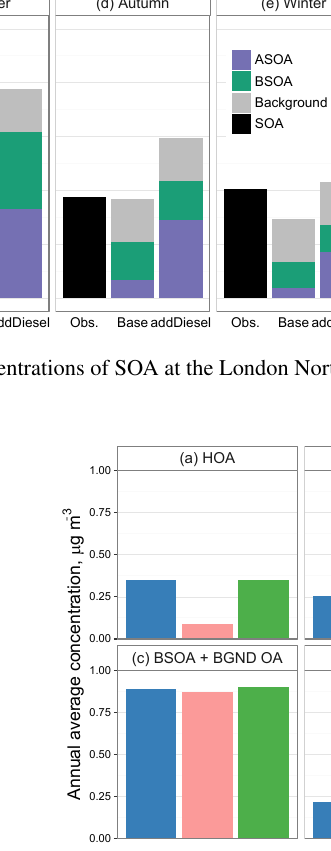
Figure 18. Simulated annual and seasonal average concentrations of OA components (BGND OA stands for background OA) for the London North Kensington site of three different model experiments: Base – all emissions as in officially reported emissions inventories, and POA is treated as non-volatile; 1.5volPOA – semi-volatile treat- ment of POA + IVOC emissions added as 1.5 × POA; addDiesel – Base + IVOC emissions from diesel traffic added proportionally to VOC emissions from the on-road traffic source sector (SNAP7). The last two additions are as described in the main